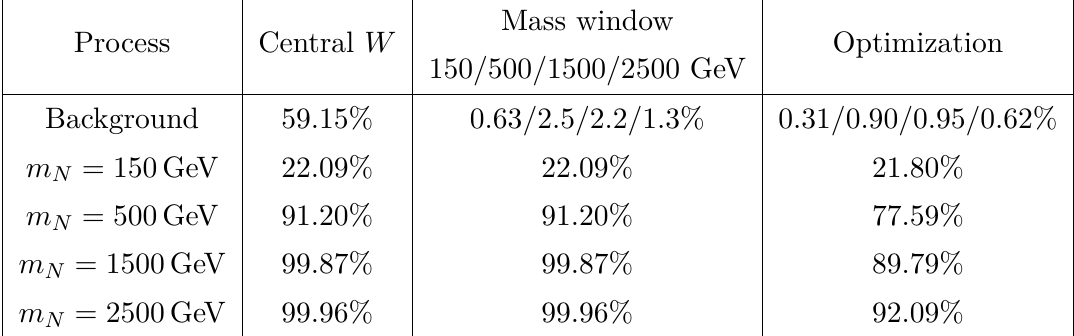
Table 9 . Cutflow table for N µ at 3 TeV. All processes after pre-selection are set to 100%. The cutflow table for individual background channels is shown in the appendix in table